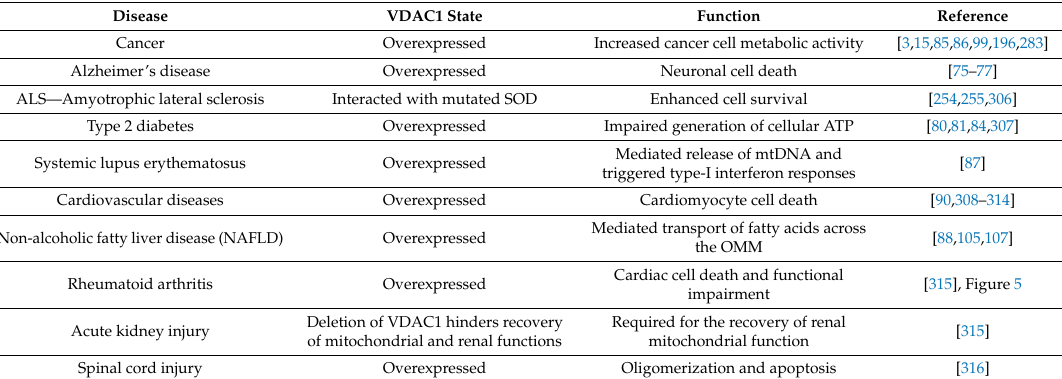
Table 3. VDAC1 association with